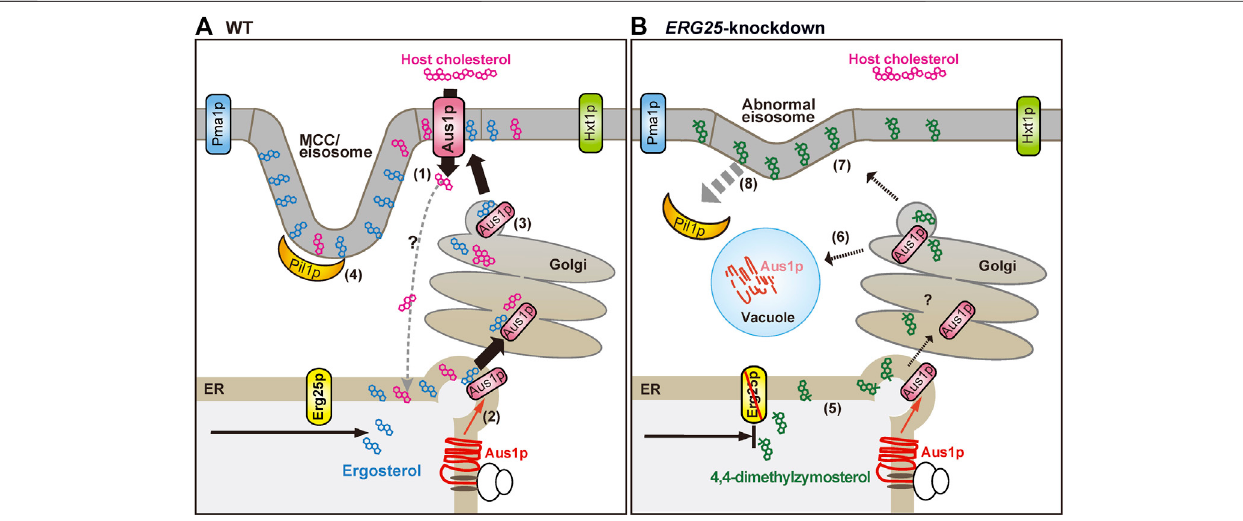
FIGURE 8 | Schematic diagram showing the proposed effects of ERG25 knockdown on host-cholesterol uptake. (A) Ergosterol and cholesterol interact with sphingolipid to form lipid domains (liquid-ordered state domain). Host-cholesterol is incorporated from serum via Aus1p, which is normally localized on the plasma membrane (1) and then transported to the endoplasmic reticulum (ER), although the transport route is unknown. In S . cerevisiae , the association of proteins with lipid domain occurs during traf fi cking from the ER to the plasma membrane via the Golgi. Therefore, newly synthesized Aus1p is inferred to be transported from the ER to the Golgi while being incorporated into lipid domains containing endogenous ergosterol (2, 3). Pil1p localizes to the membrane compartment of Can1p (MCC)/ eisosomes that are enriched in ergosterol, generating furrow-like plasma membrane invaginations (4). Aus1p-associated domains are distinct from membrane compartment of Pma1p (MCP), membrane domains containing Hxt1p, and MCC/eisosomes. (B) In ERG25 knockdown cells, 4,4-dimethylzymosterol is contained in lipid domainsin place ofergosterol(5), but the domains arenot allowed to fi tthe Aus1p due to4,4-dimethylzymosterol. Therefore, newly synthesized Aus1p isunable to associate with lipid domain, and is missorted to the vacuole, resulting in the degradation (6). 4,4-Dimethylzymosterol, which is transported to the plasma membrane (7) and the release of Pil1p from the MCC/eisosomes (8). However, there is no effect on the localization of membrane proteins Pma1 and Hxt1.